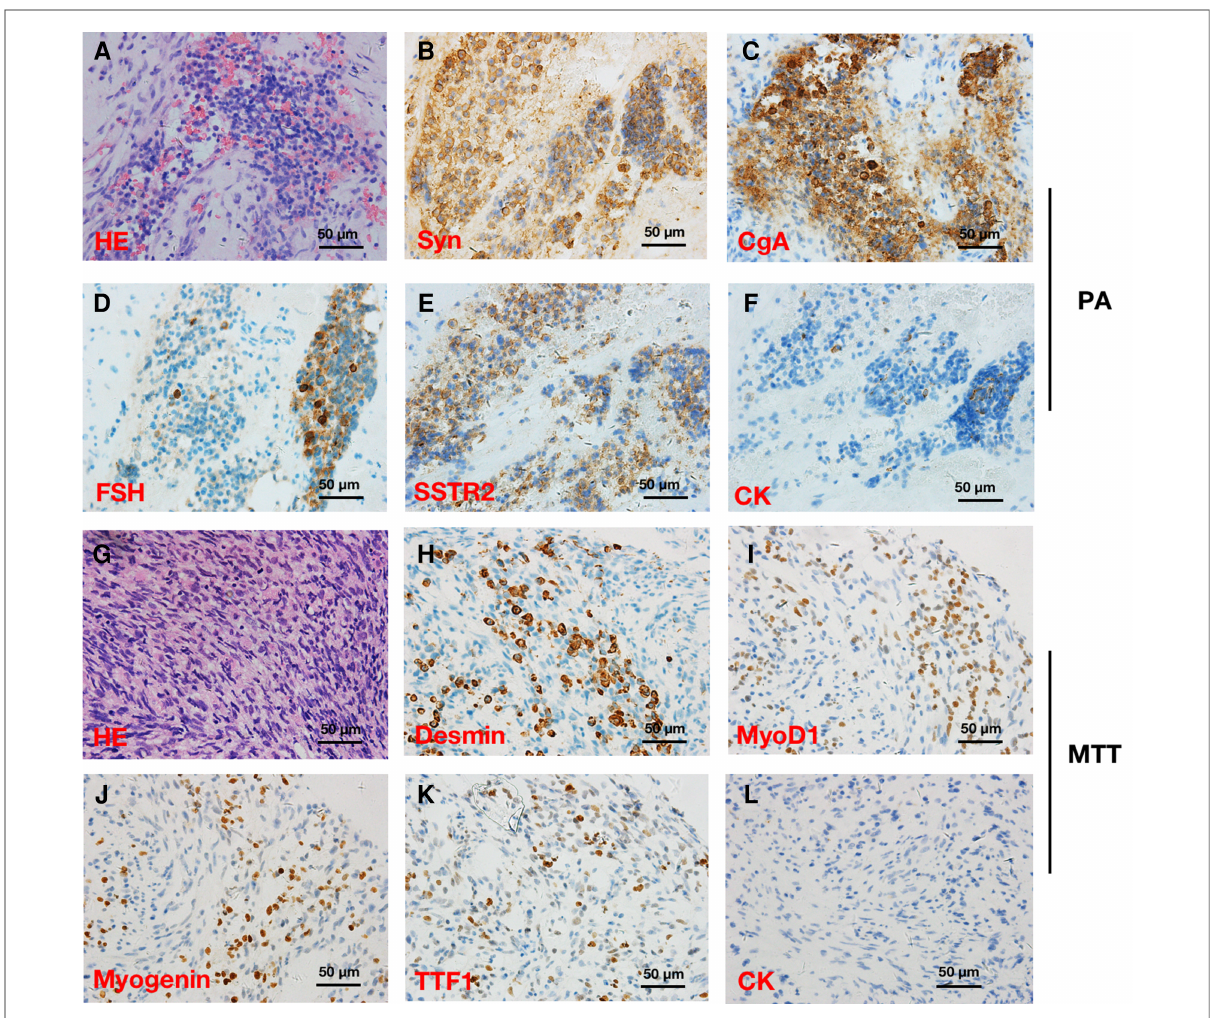
FIGURE 2 Hematoxylin and eosin (HE) and immunohistochemical stainings in a patient with pituitary adenoma (PA) ( A – F ) and concurrent intracraninal malignant triton tumor (MTT) (×400) ( G – L ). HE ( A ) and immunoreactivity of synaptophysin (Syn) ( B ), chromogranin A (CgA) ( C ), follicle-stimulating hormone (FSH) ( D ), somatostatin receptor 2 (SSTR2) ( E ), and cytokeratin (CK) ( F ) supported the diagnosis of PA. Round and fussiform cells with eosinophilic cytoplasm morphologically consistent with rhabdoid differentiation were observed in HE staining ( G ). Desmin ( H ), Myogenin ( I ),